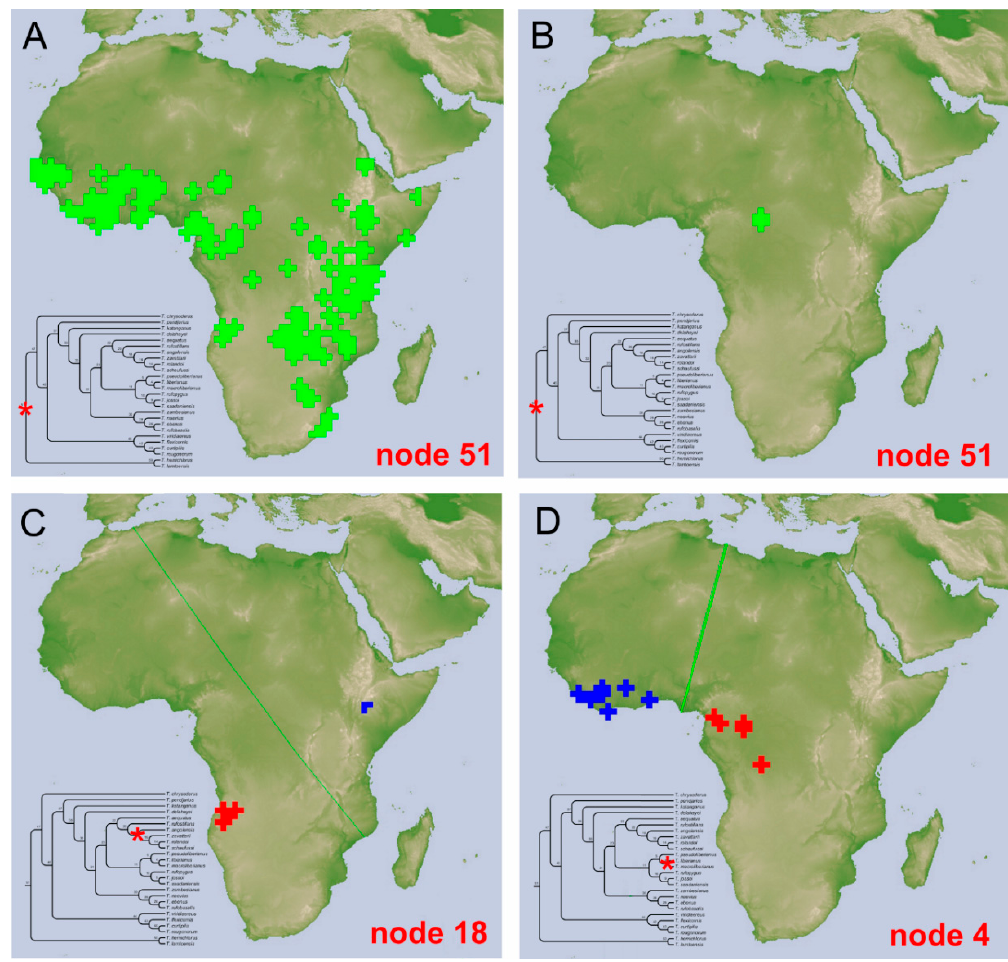
Figure 5. Vicariance Inference Program (VIP) reconstruction maps, with the corresponding node marked on the tree (red asterisk). ( A ): Map of OR (i.e., original or default) reconstruction at node 51. ( B ): Map of consensus reconstruction at node 51. ( C ): map of consensus reconstruction at node 18. ( D ): map of consensus reconstruction at node 4, with the Voronoi line in green. In the reconstructions, the allopatric distributions were defined by using different colours (red and blue) for each descendant, while overlaps were displayed in green.